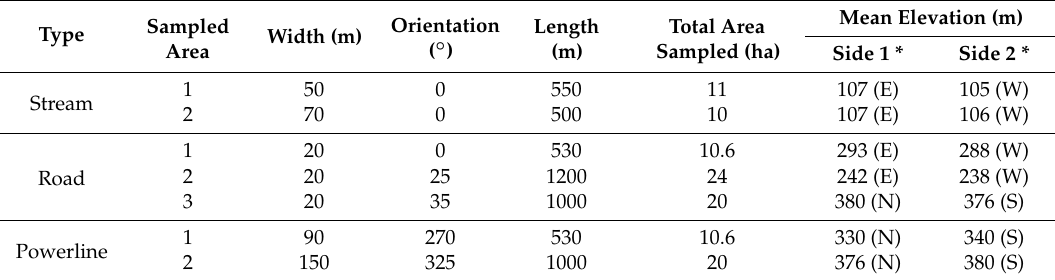
Table 1. General characteristics of the selected linear